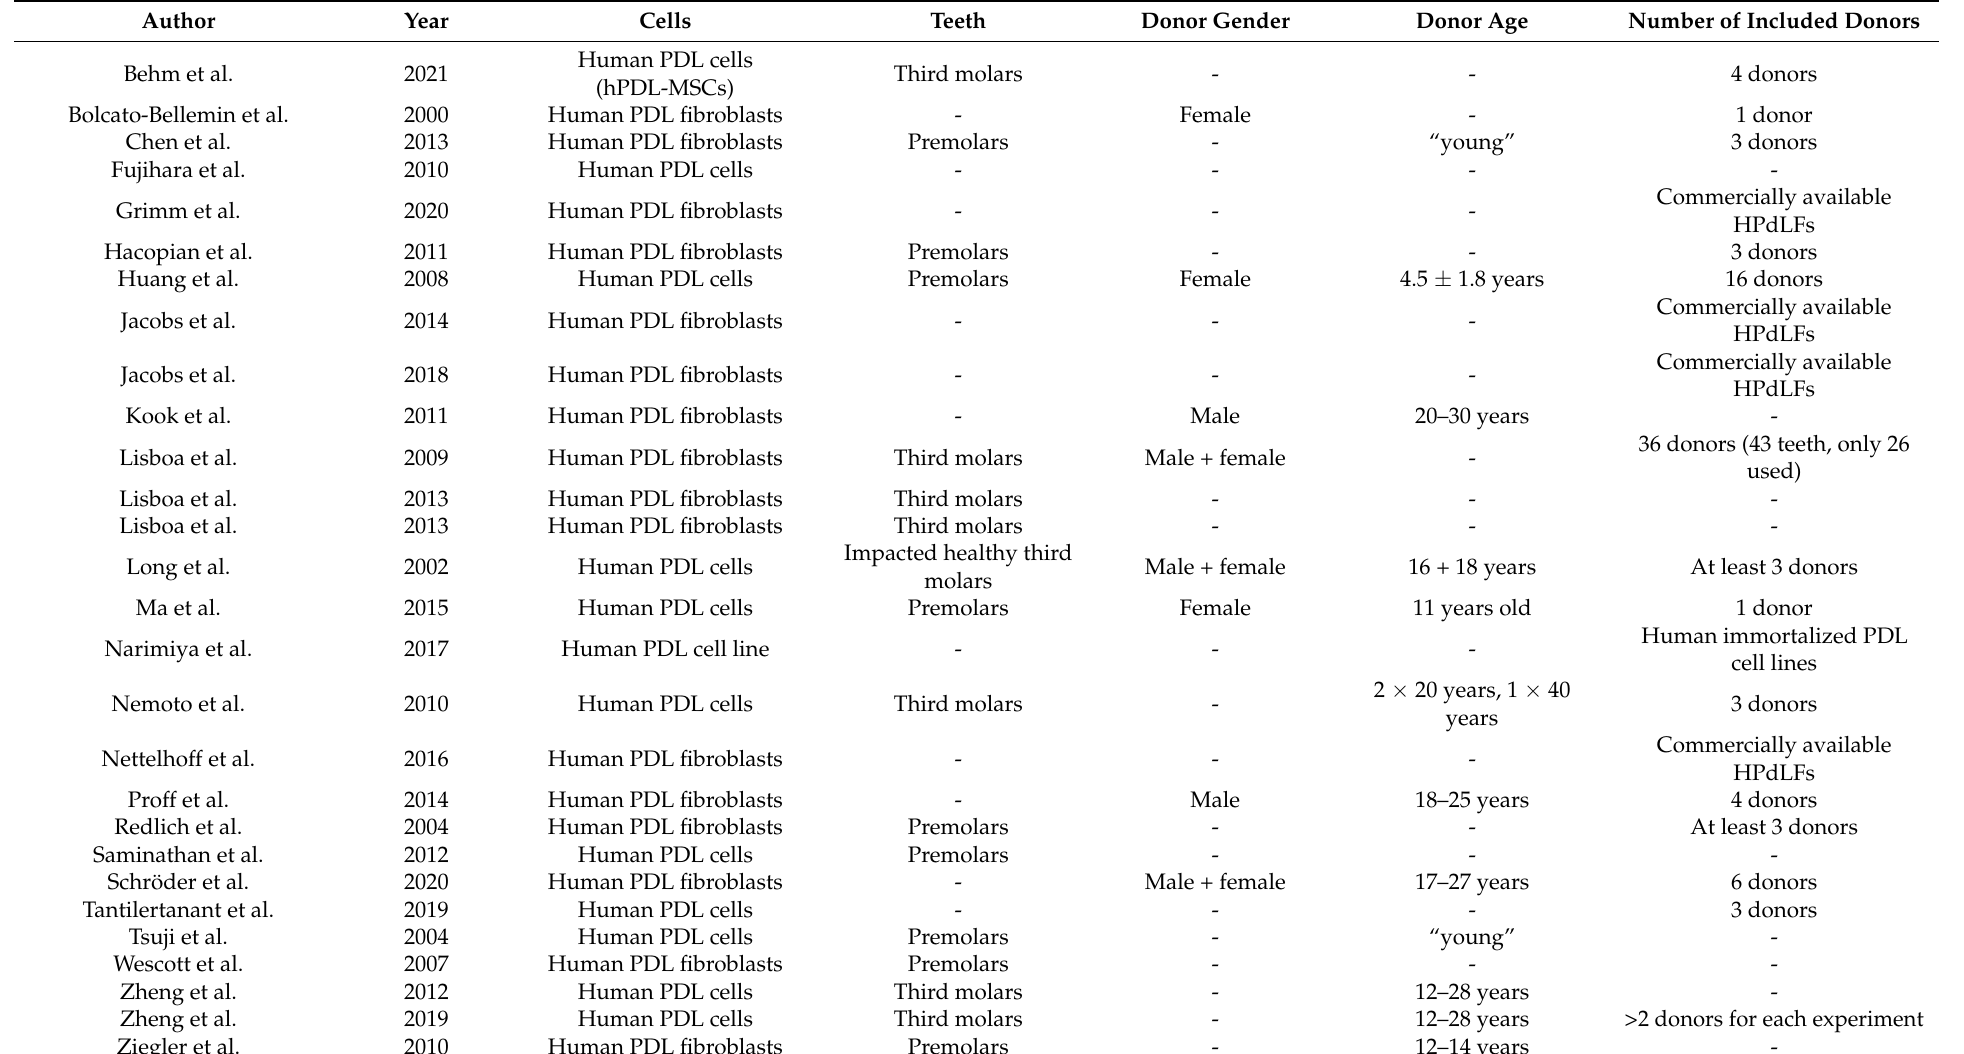
Table 1. Sample parameter of all included in vitro